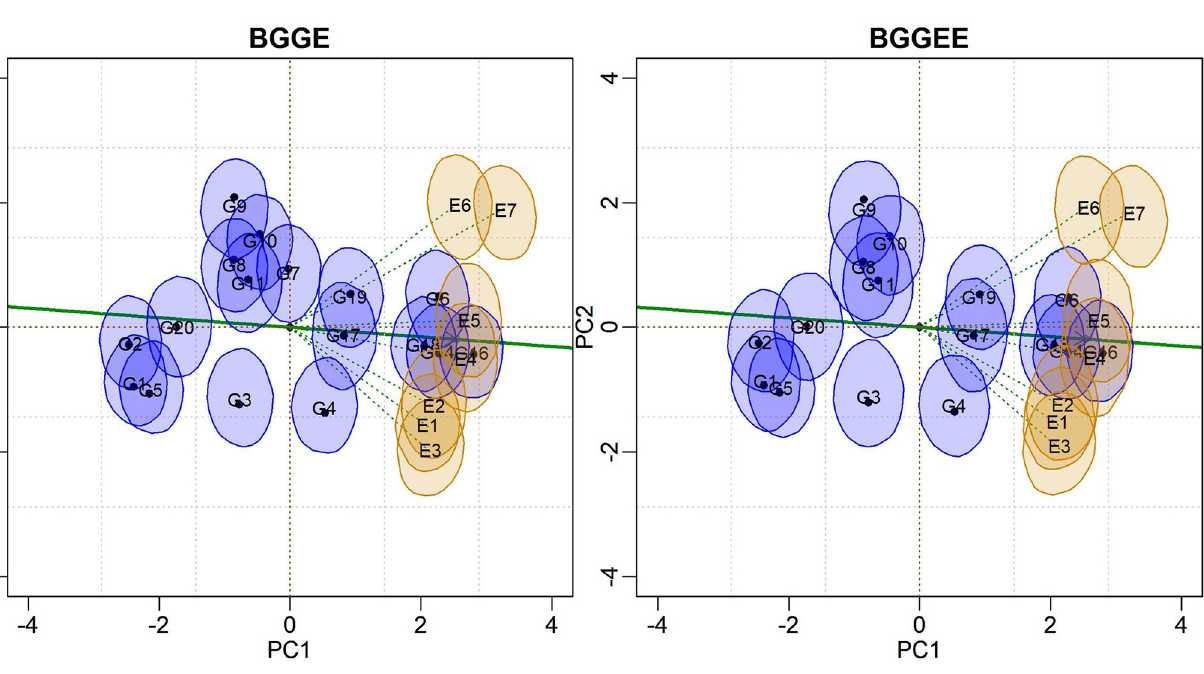
Fig 3. Biplots with 95% credible bivariate regions for the BGGE (Bayesian-GGE) and BGGEE (Bayesian-GGE entropy) models’ genotypic and environmental scores.